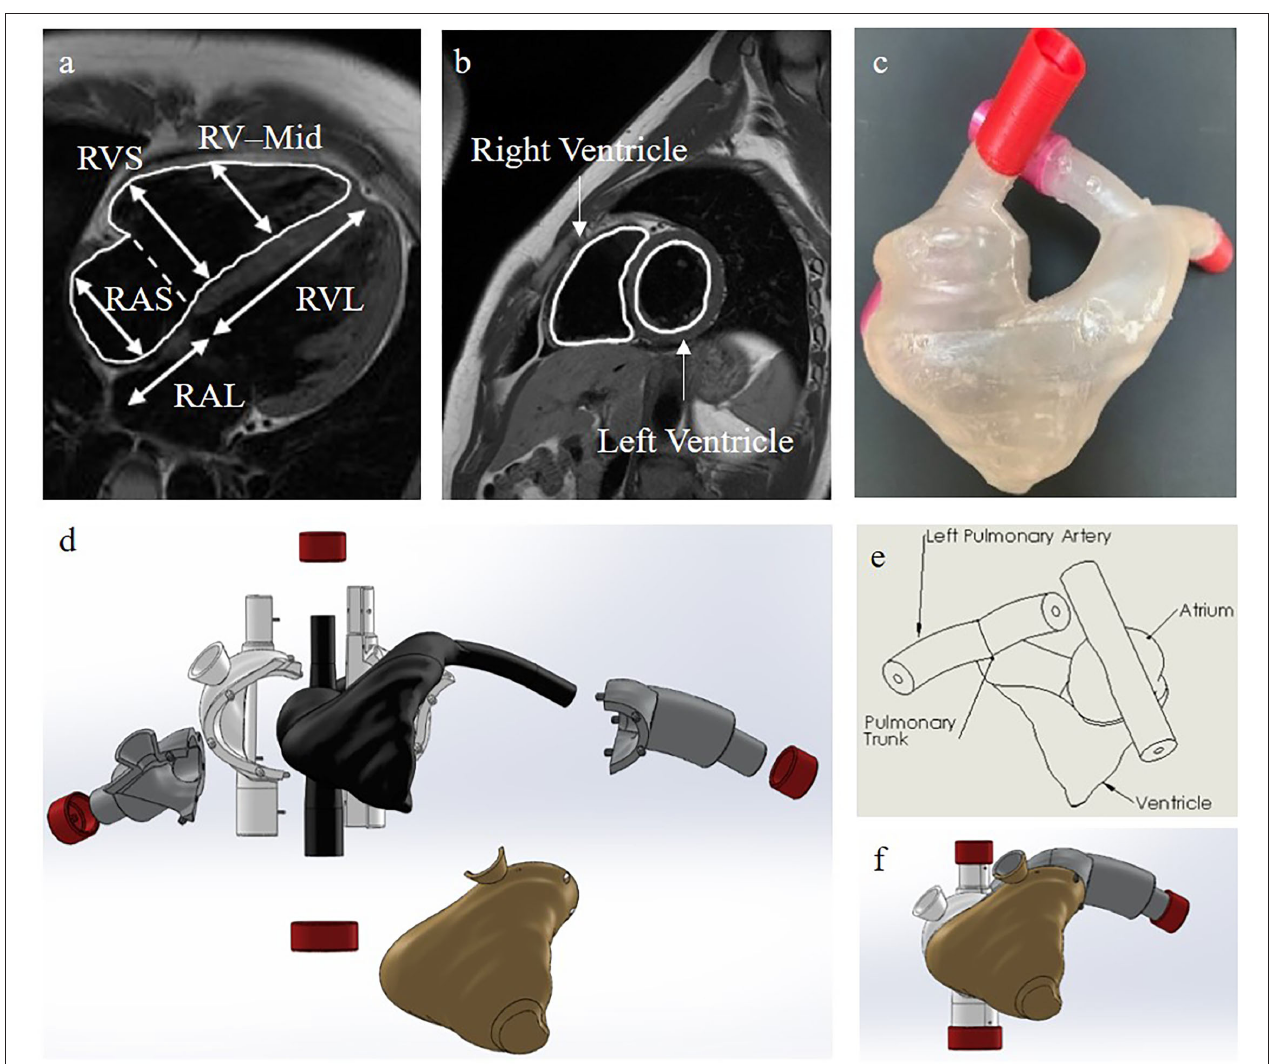
FIGURE 3 | Our heart model. (a) Side view of the internal right side of the heart with the dimensions used for verification of our heart model in Table 2 . RVS, Right Ventricular Short Axis; RAS, Right Atrial Short Axis; RV-Mid, Right Ventricular Midway Axis; RVL, Right Ventricular Long Axis; RAL, Right Atrial Long Axis (34). (b) Cross-sectional MRI images of the heart for 3D reconstruction ( 34). (c) Our final casted heart model. (d) A color-coded exploded view of the internal and external SolidWorks models of the molds used for casting our final heart model. Black is for the internal heart mold, gold is for the ventricle mold, gray is for the pulmonary artery molds, white is for the atria and vena cava molds, and red is for the end caps. (e) A labelled schematic drawing of the SolidWorks reconstructed internal heart mold. (f) The collapsed view of the SolidWorks